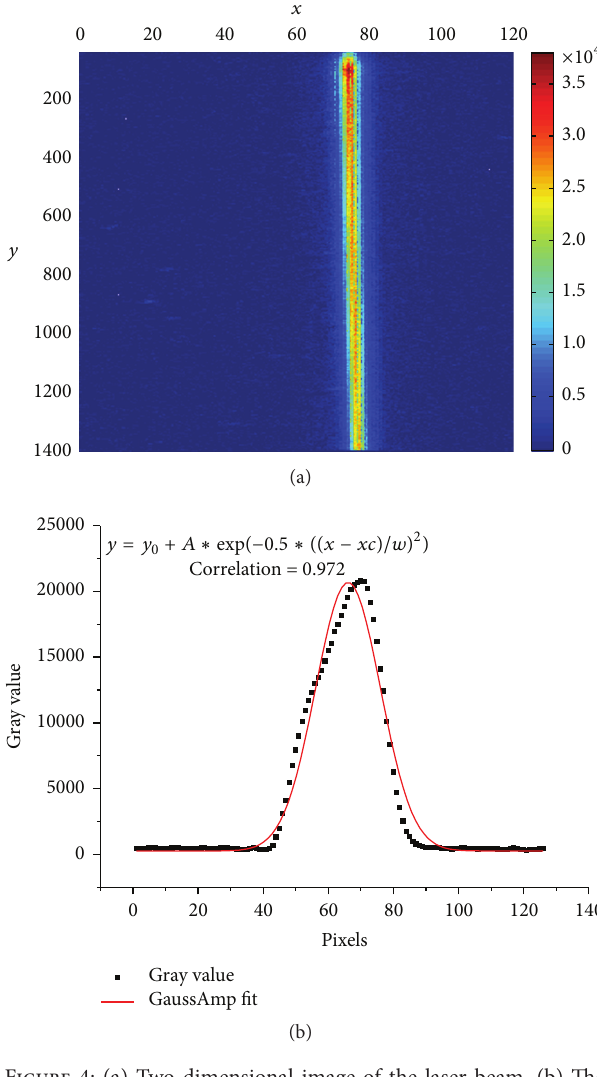
Figure 4: (a) Two-dimensional image of the laser beam. (b) The scatter diagram of the pixels and its corresponding gray scales perpendicular to the direction of the laser